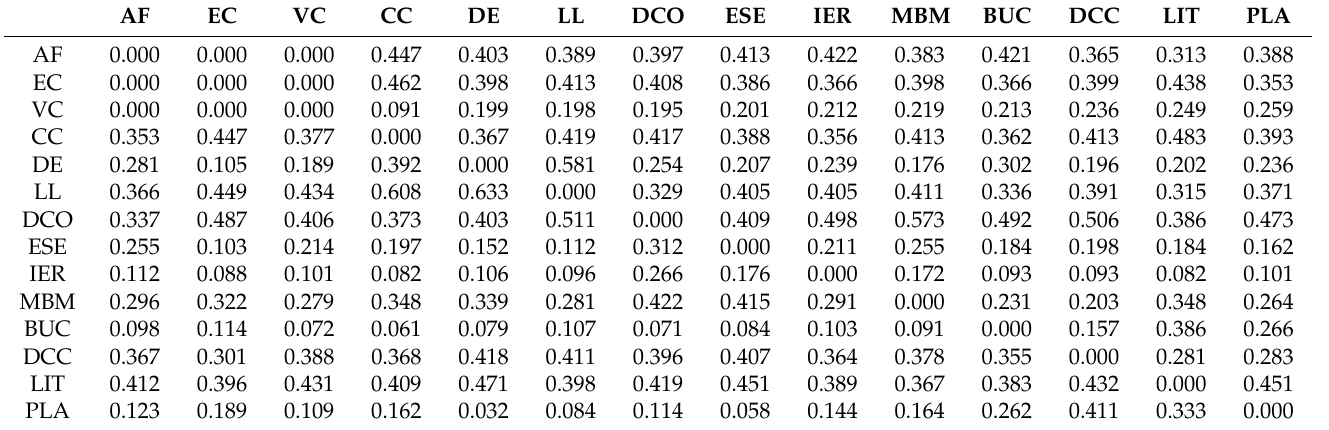
Table A2. The unweighted